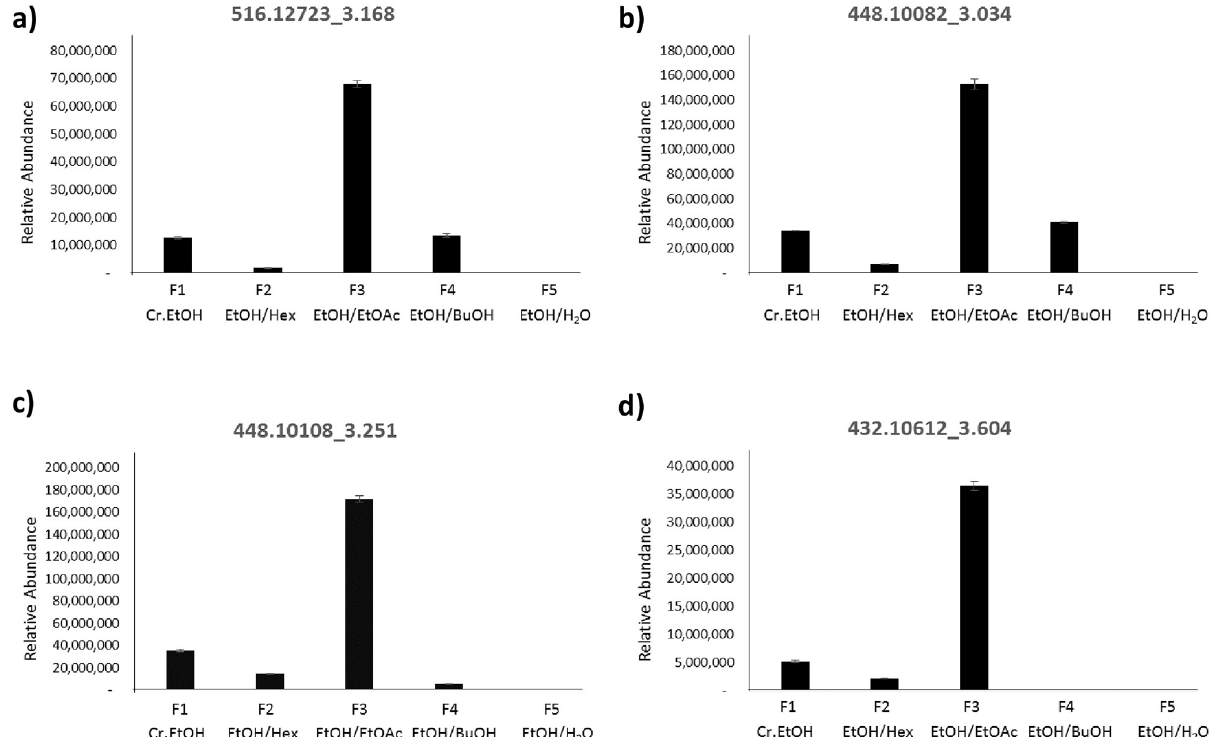
Fig 4. The levels of four significant metabolite features in different subfractions. a) ESI+516.12723_3.168, b) ESI+448.10082_3.034, c) ESI +448.10108_3.251 and d) ESI+432.10612_3.604.